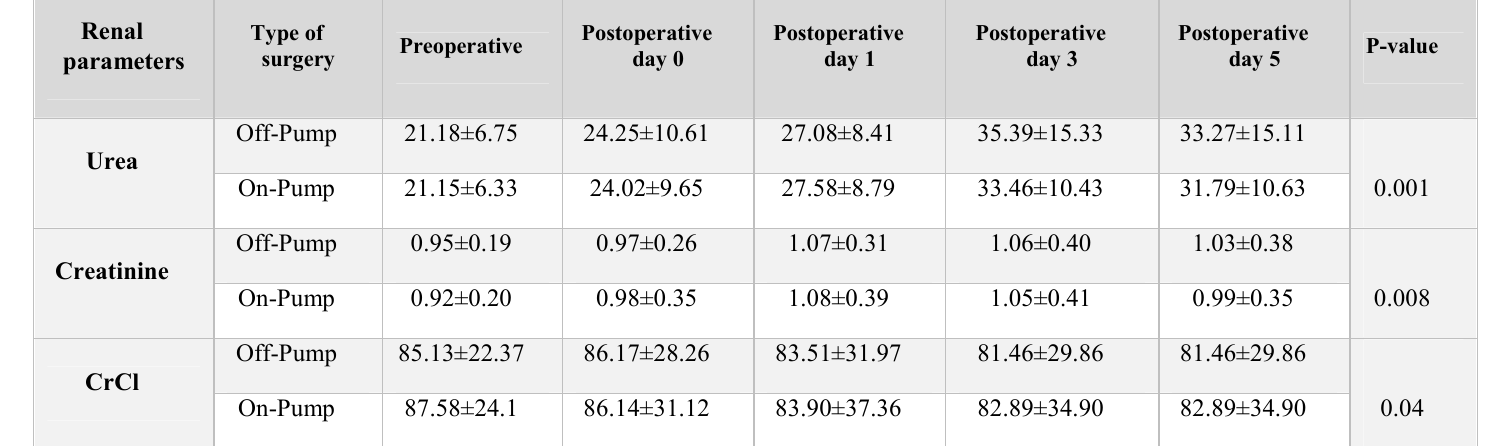
Postoperative day 0